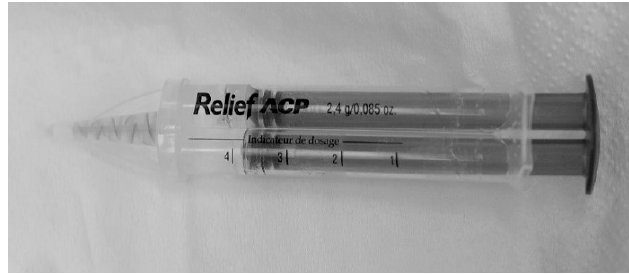
Figure 1. Amorphous calcium phosphate (ACP) desensitizing gel was employed in this study.